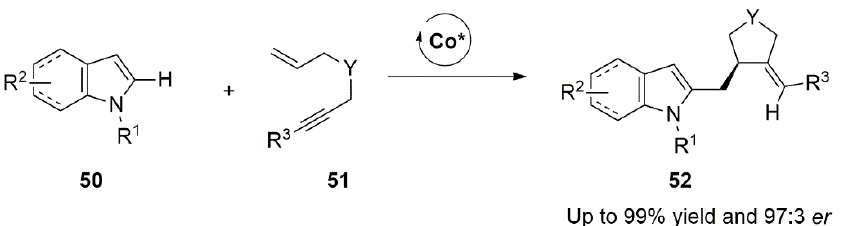
Figure 26. Cobalt/(R,R)-QuinoxP catalytic systems in the cyclization of enynes ( 51 ) with indole derivatives ( 50 ).